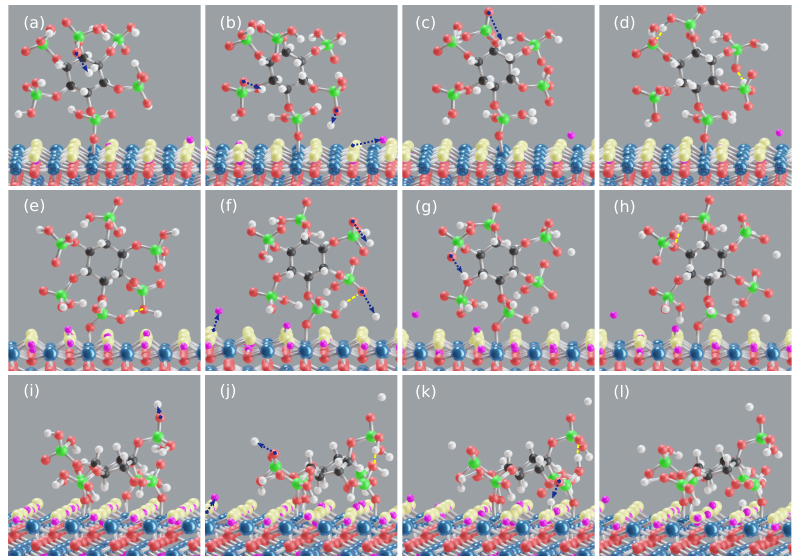
Figure 4. Snapshots along the simulation trajectories of the goethite–IHP–water complexes. IHP M motif ( a – d ), IHP B motif ( e – h ), IHP 3M motif ( i – l ). Arrows denote proton transfers from phosphates to water and from goethite to water. The yellow dotted lines denote intramolecular HBs between IHP’s phosphate groups. For all cases, the first two snapshots are from equilibration phase while the last two are from production, except for the IHP 3M motif case where only ( i ) is from the equilibration phase. The last snapshot for each case is taken at 25 ps. The goethite’s hydrogen atoms and IHP’s hydrogen atoms are shown in violet and white colors, respectively, for clear visualization of proton transfer events. Blue, red, yellow, black and green colors correspond to iron, oxygen, hydroxyl oxygen, carbon and phosphorus atoms, respectively. The surrounding water is ignored here for better